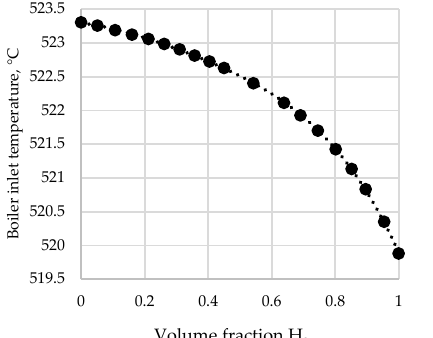
Figure 12. Dependence of the temperature of the working fluid and the output power on the hydro- gen volume fraction.